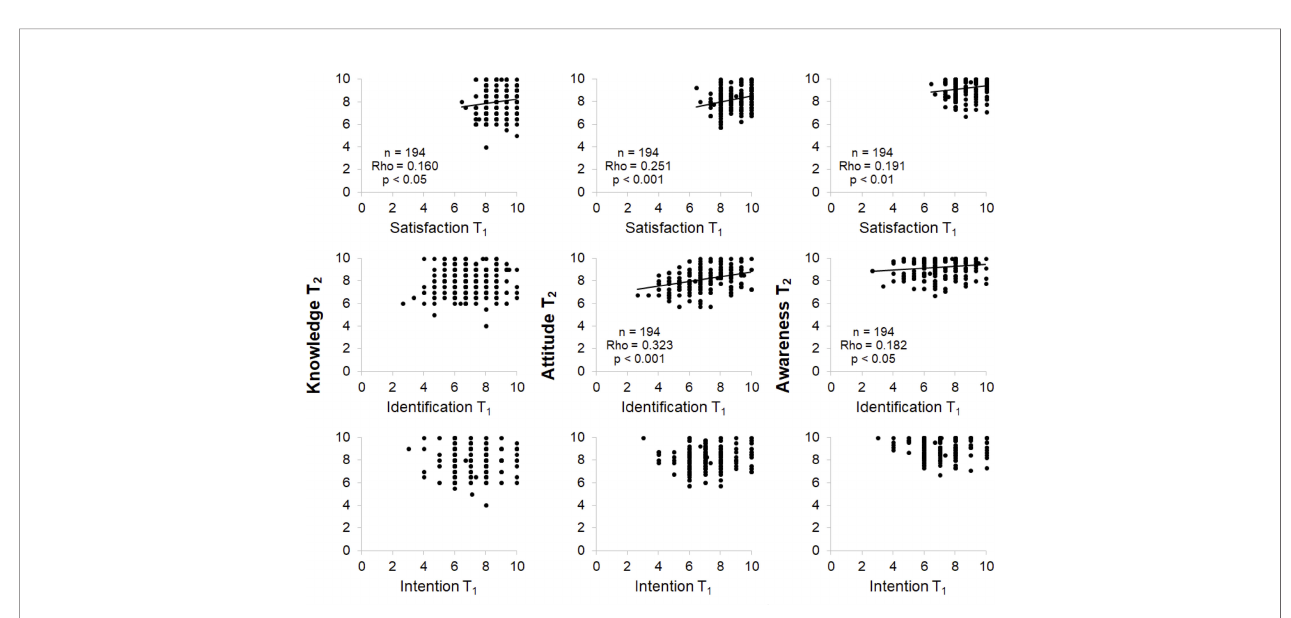
FIGURE 5 | Correlation plots between sustainability variables (knowledge, attitude, awareness) at T 2 and psychological variables (satisfaction, identi fi cation, intention) at